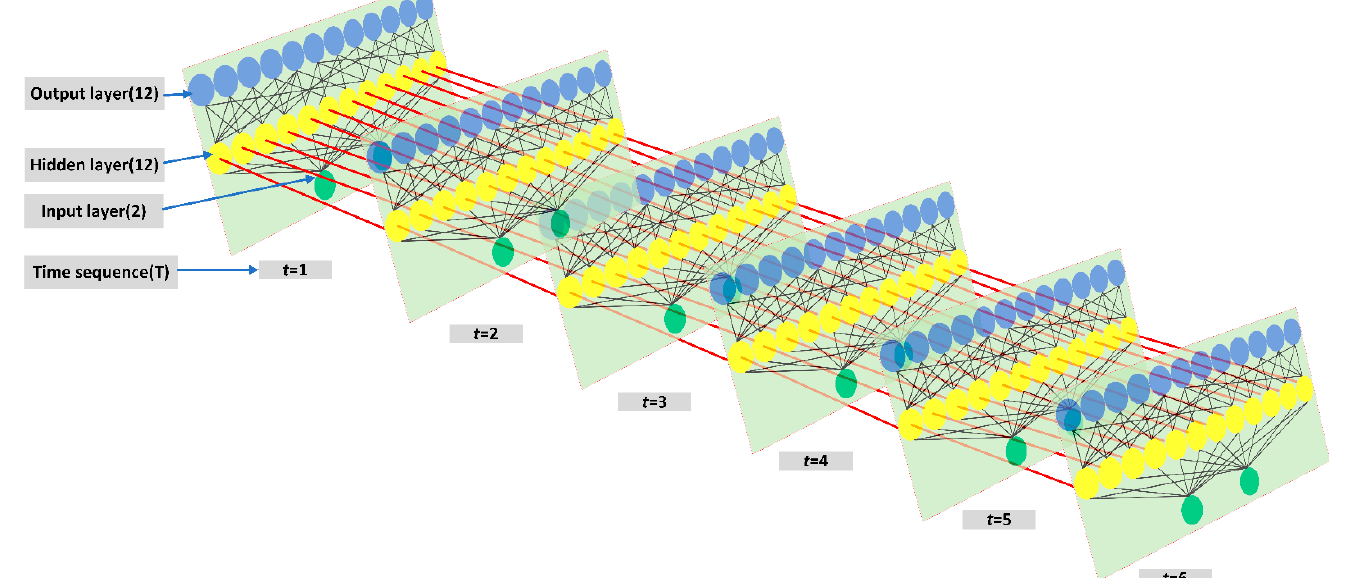
Figure 7. LSTM_Out. Electronics 2022 , 11 , 4057